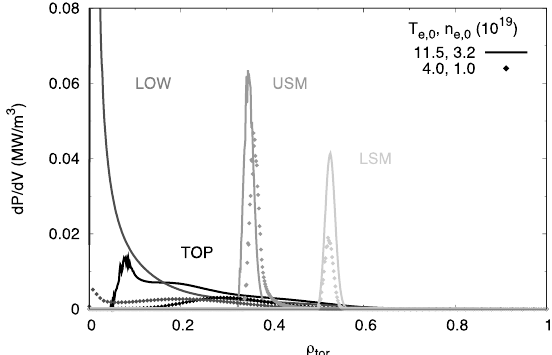
Fig. 6. Power deposition profile for different T e , n e scaling (T e,0 in keV, n e,0 in m -3 )